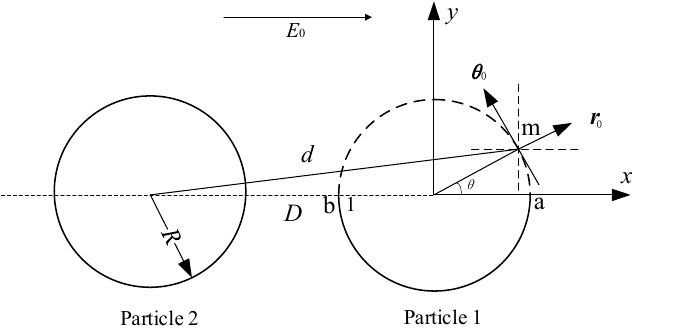
Figure 2. The calculation model for the two ‐ particle system in the transverse external electric field.